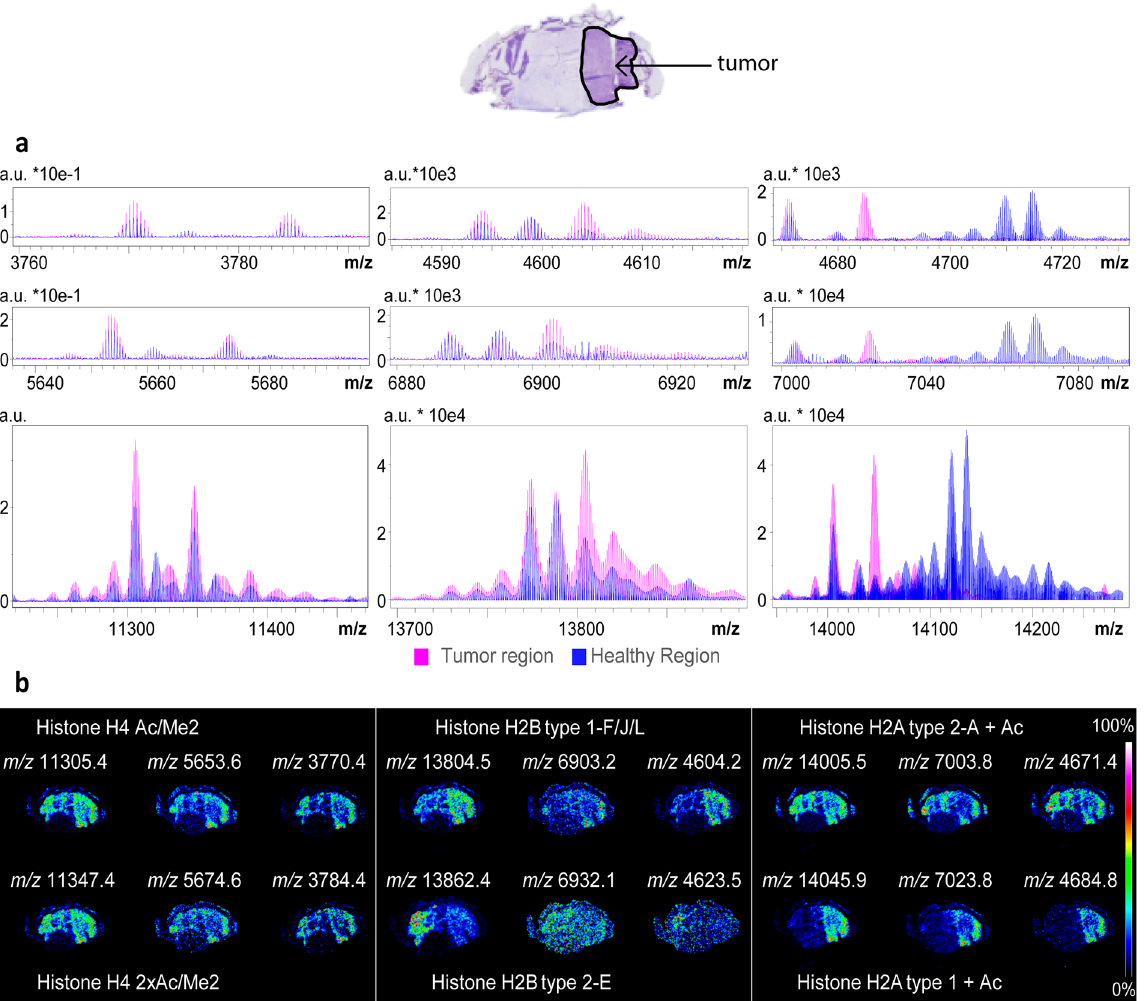
Figure 3. Differential regulation of histone proteoforms. ( a ) Overlay of the average mass spectra extracted for the tumor ROI (pink) and the healthy ROI (blue), showing the mass ranges of the triply (top), doubly (middle), singly (bottom) charged ions of Histone H4 (left), Histone H2B (middle), Histone H2A (right). ( b ) MS images for some of the detected proteoforms; protein assignments were made via alignment with the LC-MS/MS results for microdissected samples of tumor and healthy regions of